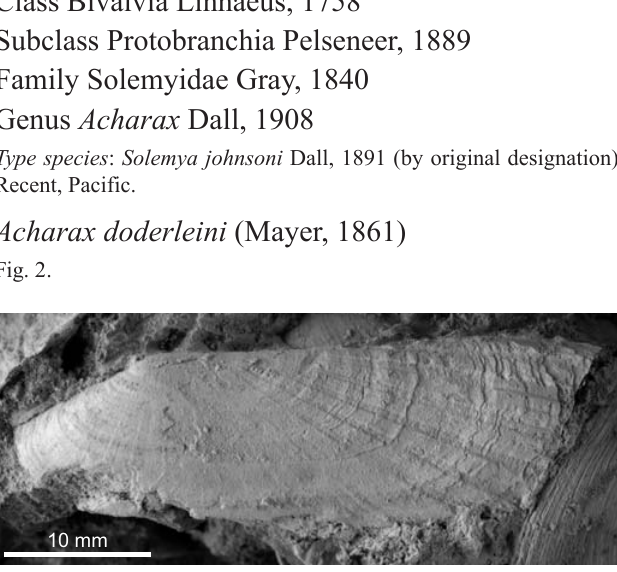
Fig. 2. The solemyid bivalve Acharax doderleini (Mayer, 1861) from the late Pliocene of Italy, Stirone River seep deposit; MGGC.22007 view on exterior of right